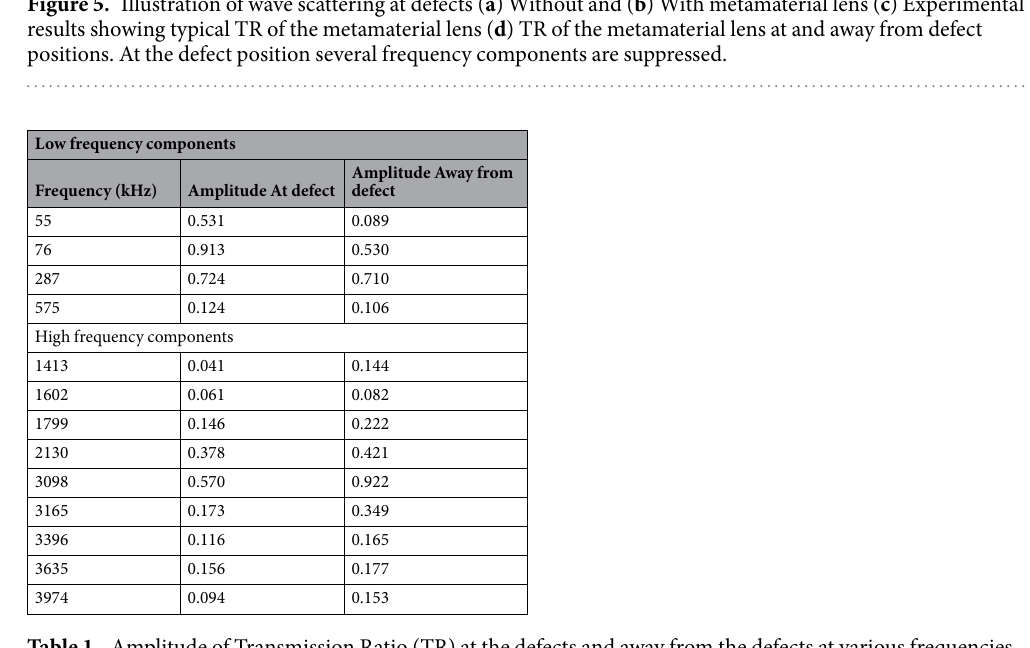
Table 1. Amplitude of Transmission Ratio (TR) at the defects and away from the defects at various